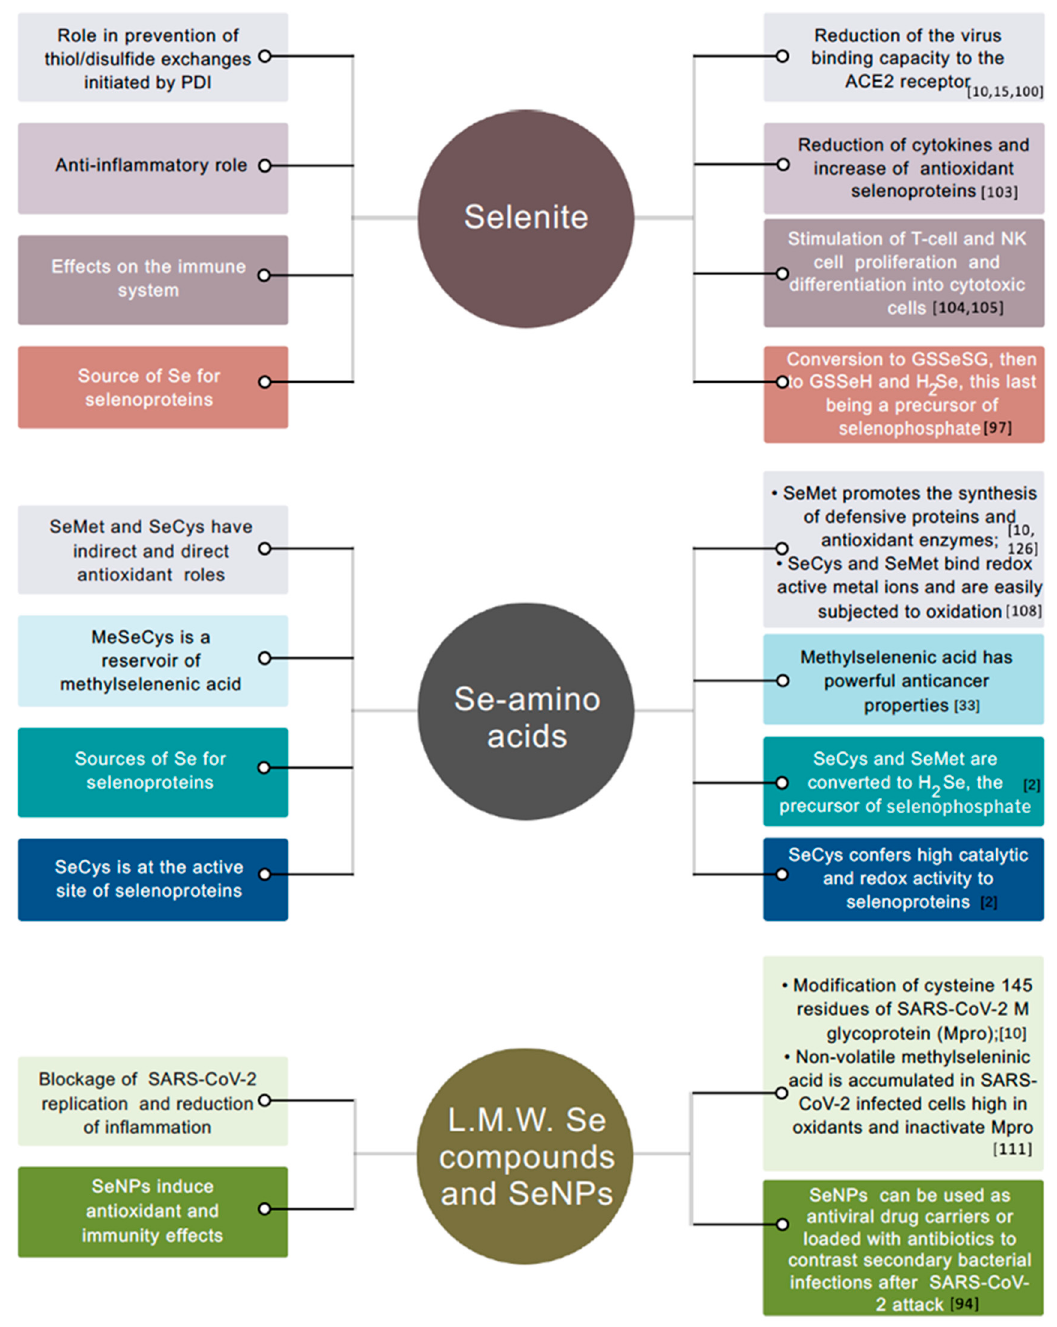
Figure 2. Left: principal roles of selenite, Se-amino acids, low molecular weight (L.M.W.) Se compounds, and seleno nanoparticles (SeNPs) in immunity and antioxidant processes in human cells. Right: mechanisms of action, either hypothesized or ascertained. The same color of the squared panels indicates association between role and mechanism of action.